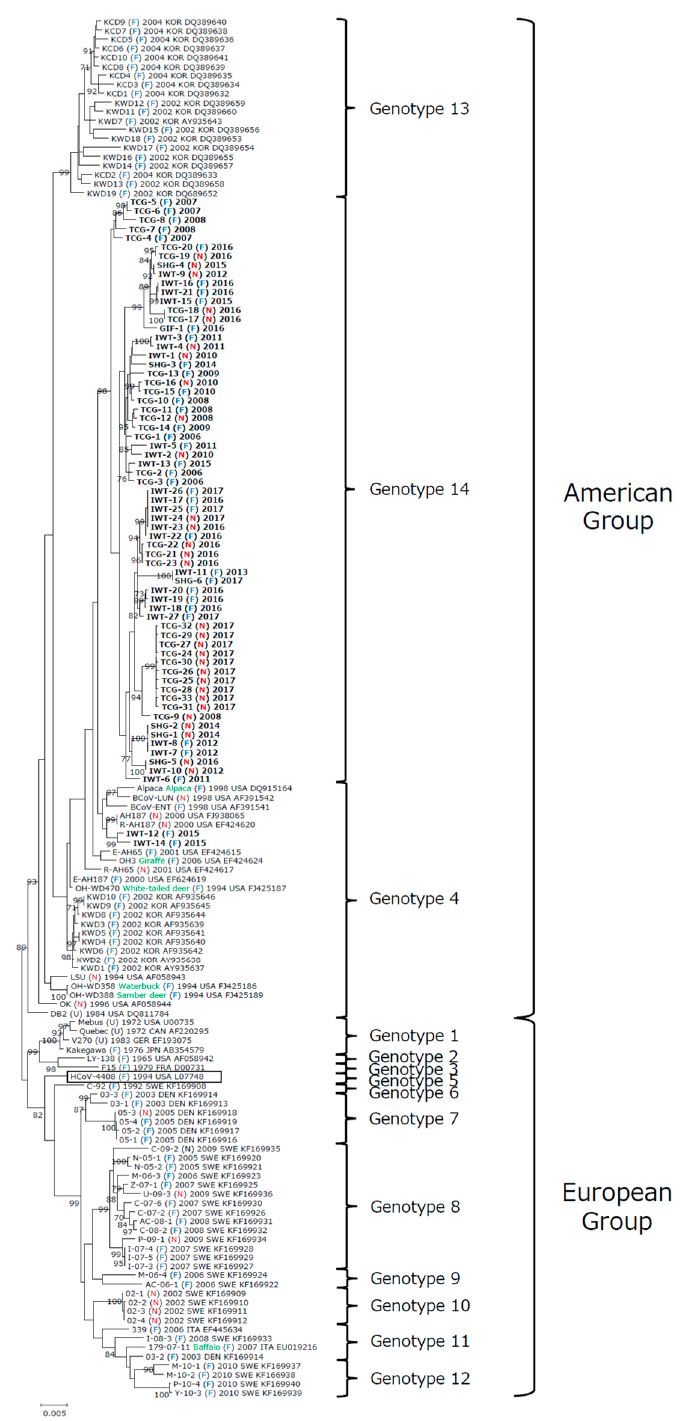
Figure 2. Phylogenetic tree constructed using complete sequences of spike glycoproteins from 67 recent BCoV isolates collected from Japan, previously reported BCoV strains collected in the United States, Canada, Sweden, Denmark, Italy, Germany, France, and Korea, and human enteric coronavirus (HCoV-4408). The tree was constructed using the maximum-likelihood method with the general time reversible nucleotide substitution model implemented in the MEGA X program. Numbers at each branch represent groups with > 70% bootstrap support using 1000 replicates. Strain name, host (green): in case of wild ruminant, source: fecal sample (F), nasal swab (N), and unknown (U), year of collection, country, and the GenBank accession number are indicated. Bold text represents the Japanese BCoV isolates used in this study. Box represents human enteric coronavirus. The scale bar indicates nucleotide substitutions per site.